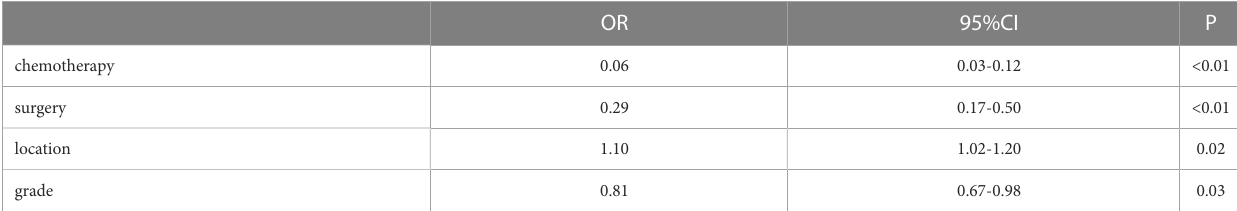
TABLE 4 Multivariable analysis OS.